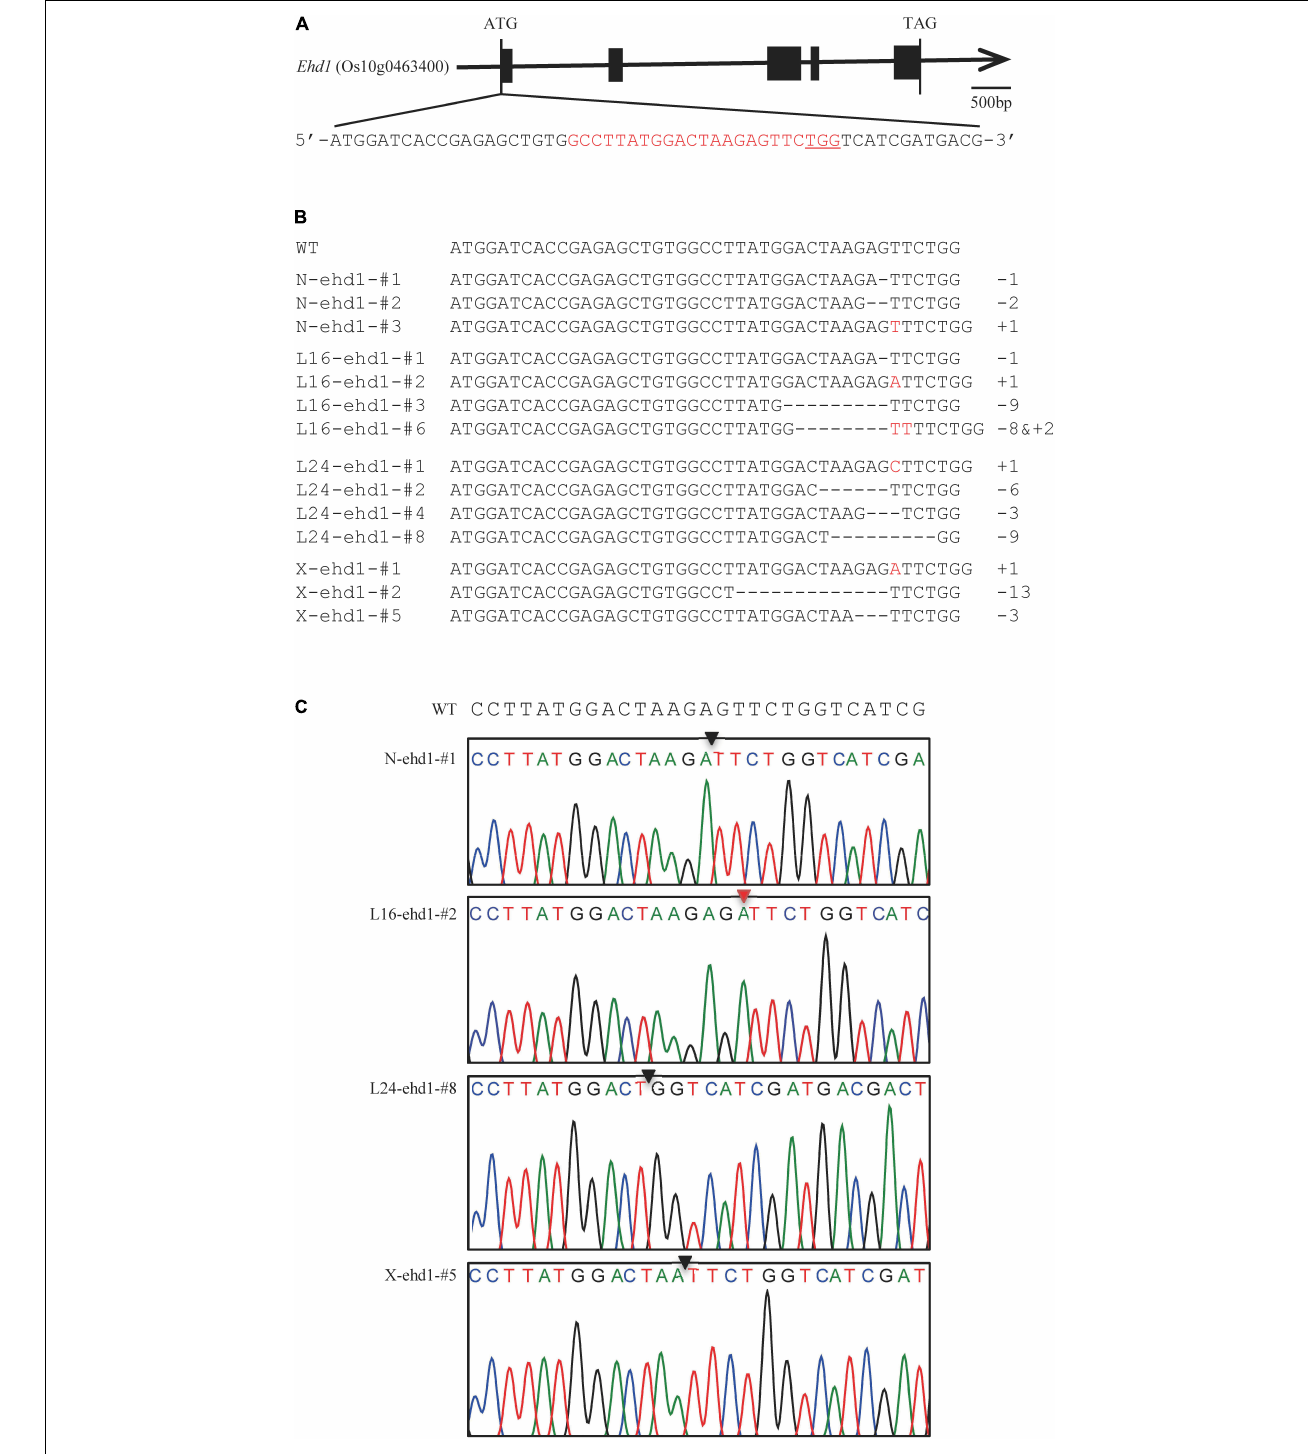
FIGURE 1 | CRISPR/Cas9-mediated genome editing of the Ehd1 gene. (A) Schematic illustration of the Ehd1 gene structure. Black rectangles represent the 5 exons of Ehd1 ; Red characters indicate the sequence of the target site; PAM sequences are underlined. (B) Examples of mutations of Ehd1 in CRISPR/Cas9-mediated mutated plants. Deletions and insertions are indicated by dashes and red letters, respectively, Numbers on the right side indicate the numbers of nucleotides involved (+, insertion; − , deletion); WT indicates wild-type sequence; N-ehd1-#, L16-ehd1-#, L24-ehd1-#, and X-ehd1-# represent the mutant plants in Nipponbare, Longdao16, Longdao24, and Xiushui134 backgrounds, respectively. (C) Examples of sequencing chromatograms of an 1 bp deletion mutant (N-ehd1-#1), an 1 bp insertion mutant (L16-ehd1-#2), a 9 bp deletion mutant (L24-ehd1-#8), and a 3 bp deletion mutant (X-ehd1-#5), in Nipponbare, Longdao16, Longdao24, and Xiushui134 backgrounds, respectively. The deletion and insertion sites are indicated by the black triangle and red triangle, respectively.